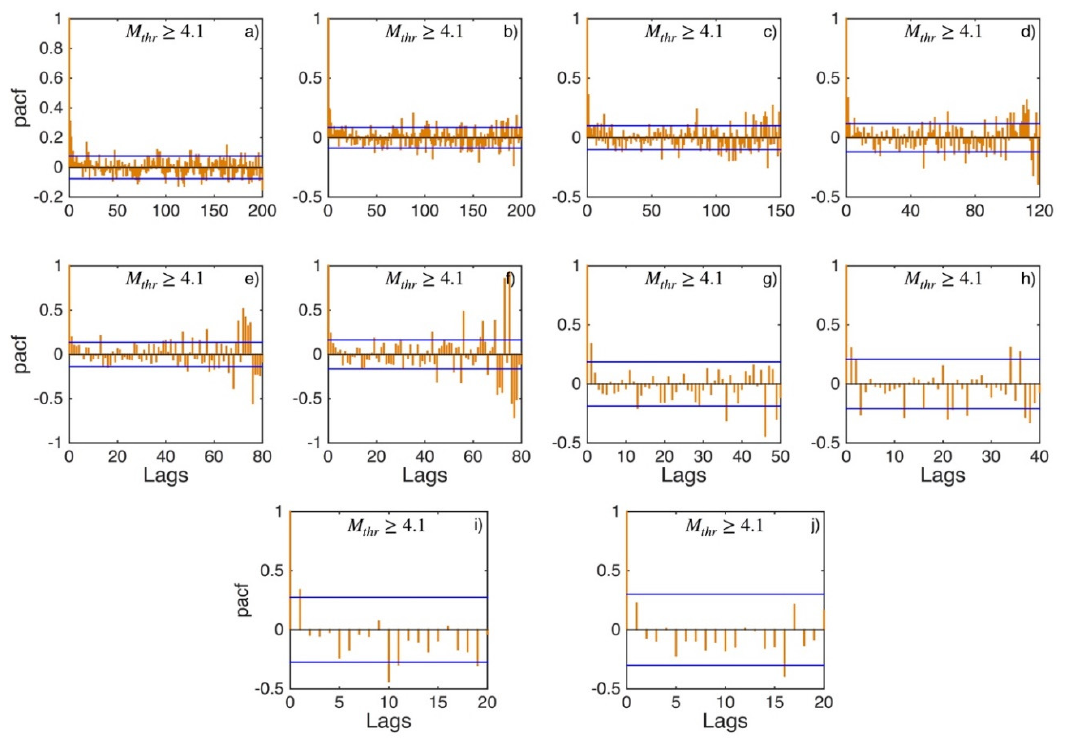
Figure A20. PACF values (orange stems) and their 95% confidence intervals (blue lines) for Central Greece (sub-area 8) for magnitude thresholds ( M thr ) varying from 4.1 to 5.0 (subplots a – j ).